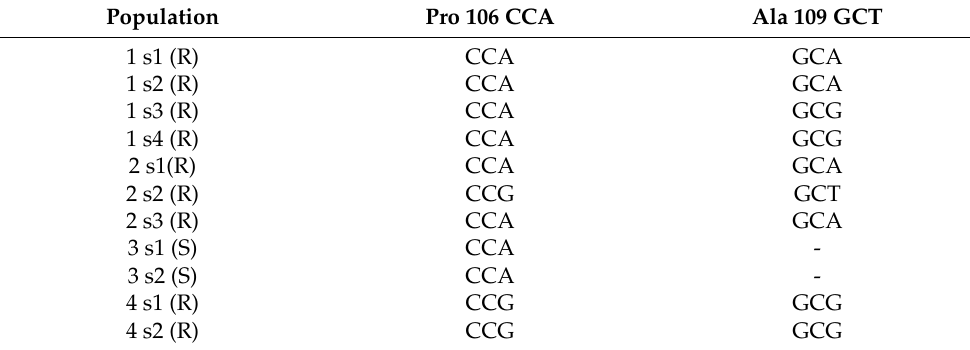
Table 5. Proline (Pro 106) and alanine (Ala 109) codons of the sequenced population samples. Population